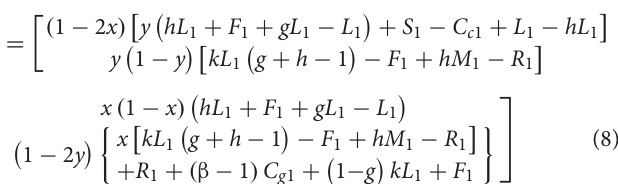
Government Ordinary supervision (1- year